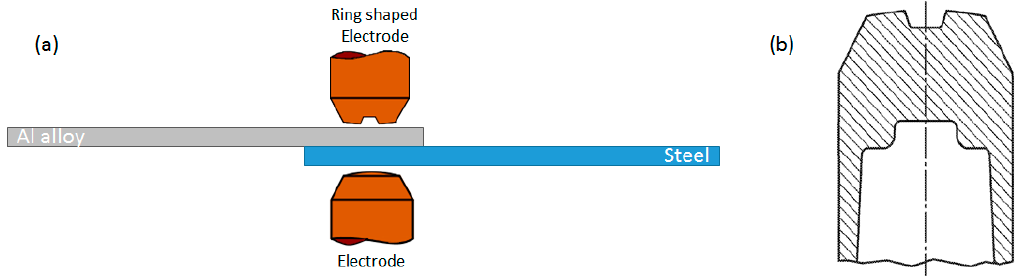
Figure 3. Resistance spot welding using a ring ‐ shaped electrode on the aluminum alloy side: overview ( a ) and ring ‐ shaped electrode ( b ) [17].